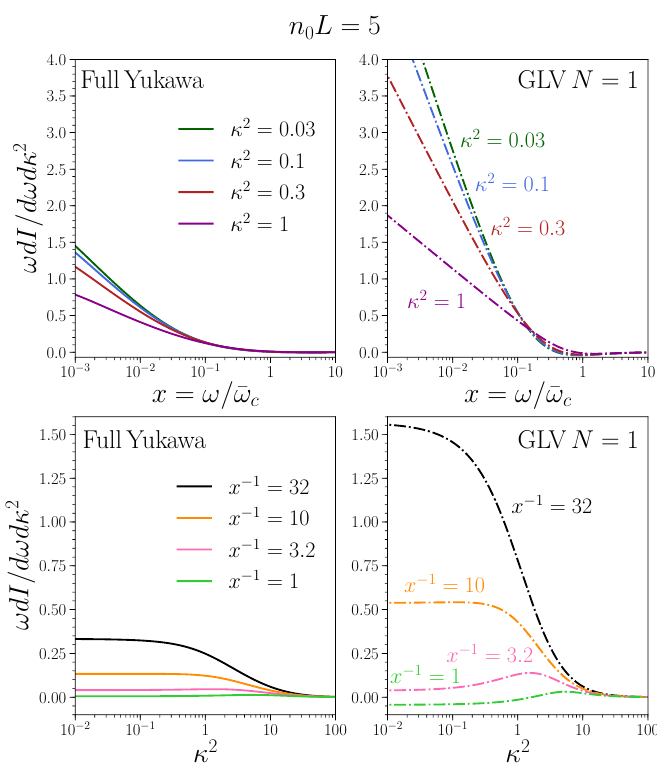
Figure 2 . Full medium-induced gluon radiation k ? -di(cid:11)erential spectrum for a medium with n 0 L = 5 for the Yukawa-type interaction (left column) compared to the GLV (cid:12)rst opacity approximation (right column). The upper panels show these spectra as function of the rescaled gluon energy x = != (cid:22) ! c for (cid:12)xed values of the rescaled gluon transverse momentum (cid:20) = k=(cid:22) . The lower panels show these spectra versus (cid:20) 2 for (cid:12)xed values of x